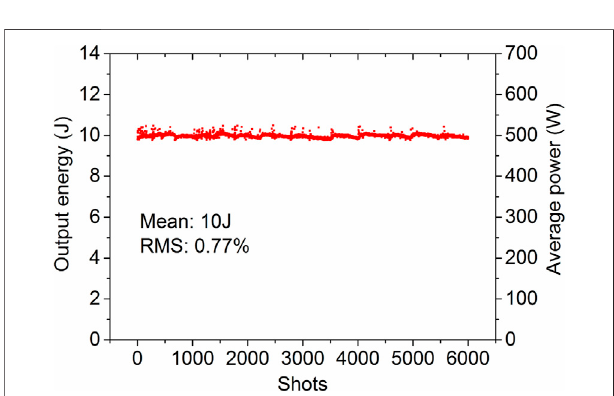
FIGURE 5 | Simulation results of different thicknesses and doping concentrations to a small signal gain.